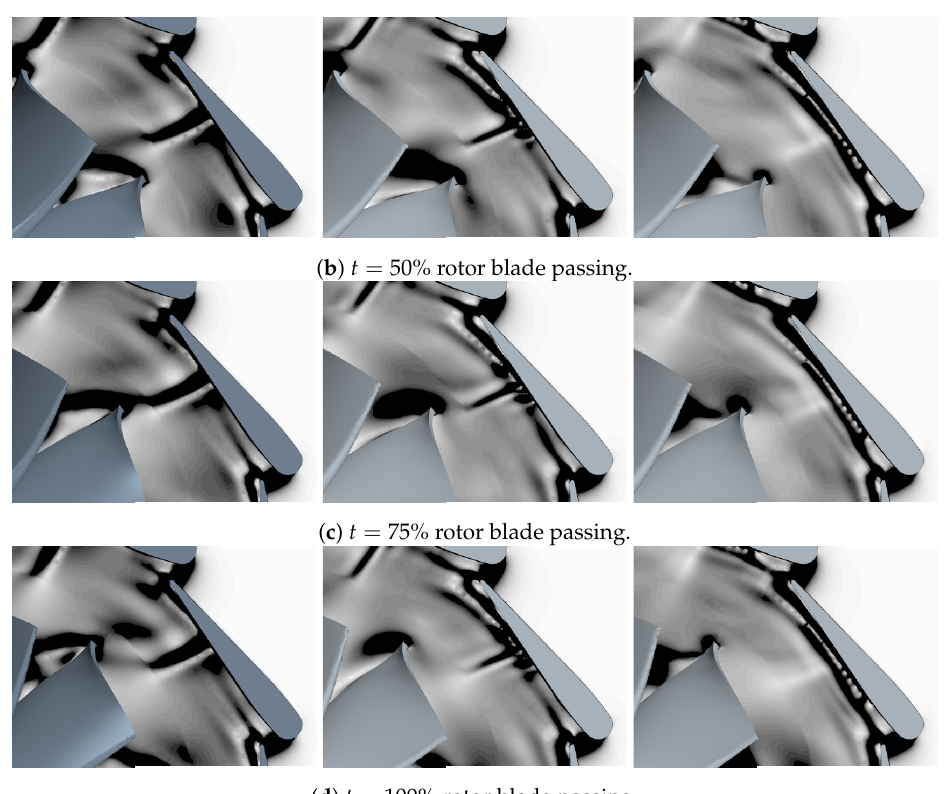
Figure 11. Transient numerical schlieren for closed VGT opening at 50% span of the stator passage with higher simulated PR and higher speed; left side: Original geometry; middle: Geometry with 5 grooves in the stator; right side: Geometry with 11 grooves in the stator.